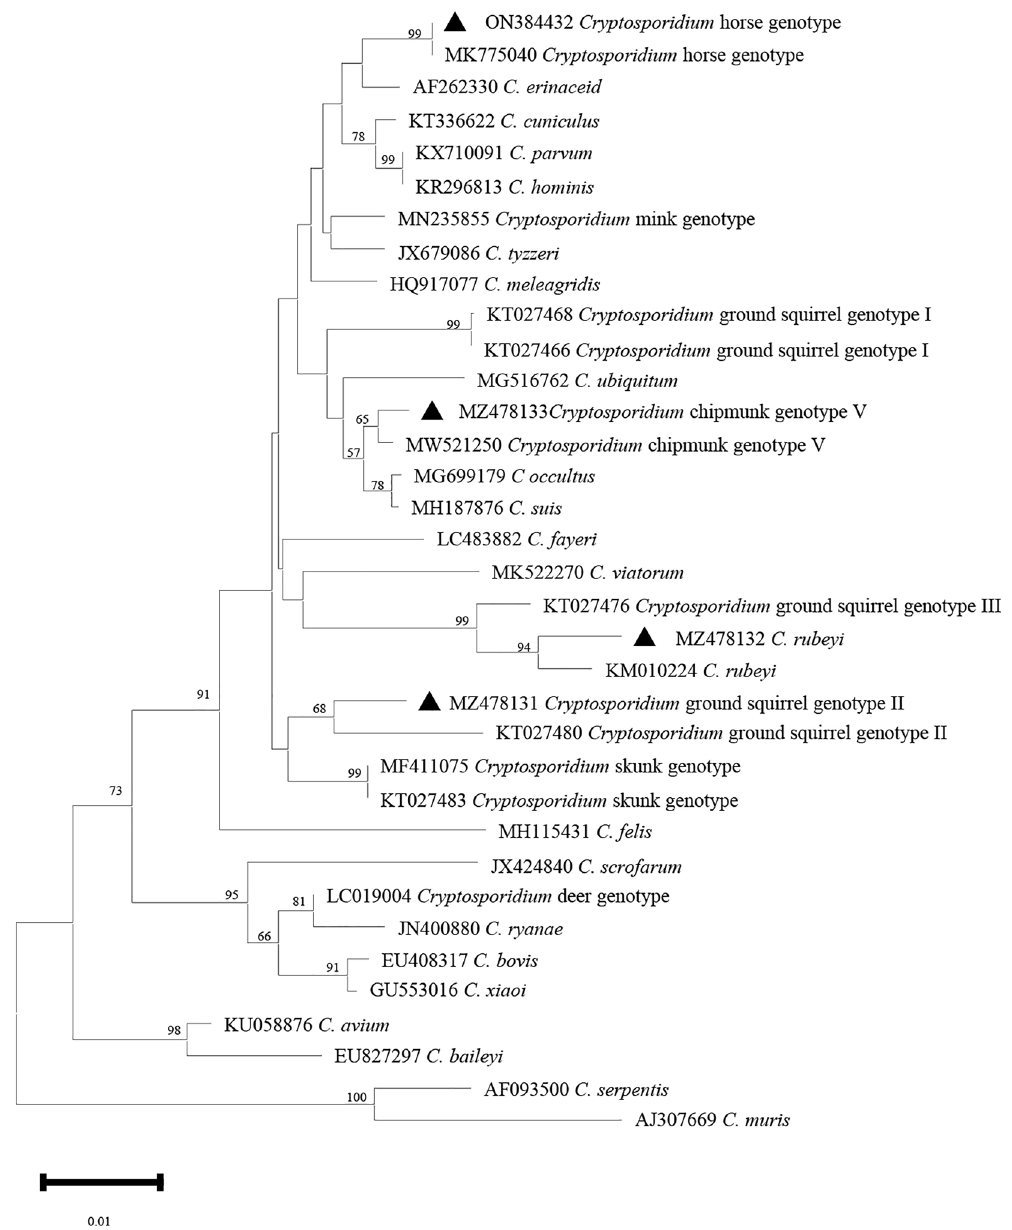
Figure 2. Phylogenetic relationship among Cryptosporidium spp. based on a neighbor-joining tree of the SSU rRNA gene. The numbers on the branches are percent bootstrapping values from 1000 replicates, and the sequences generated in the present study are indicated with the